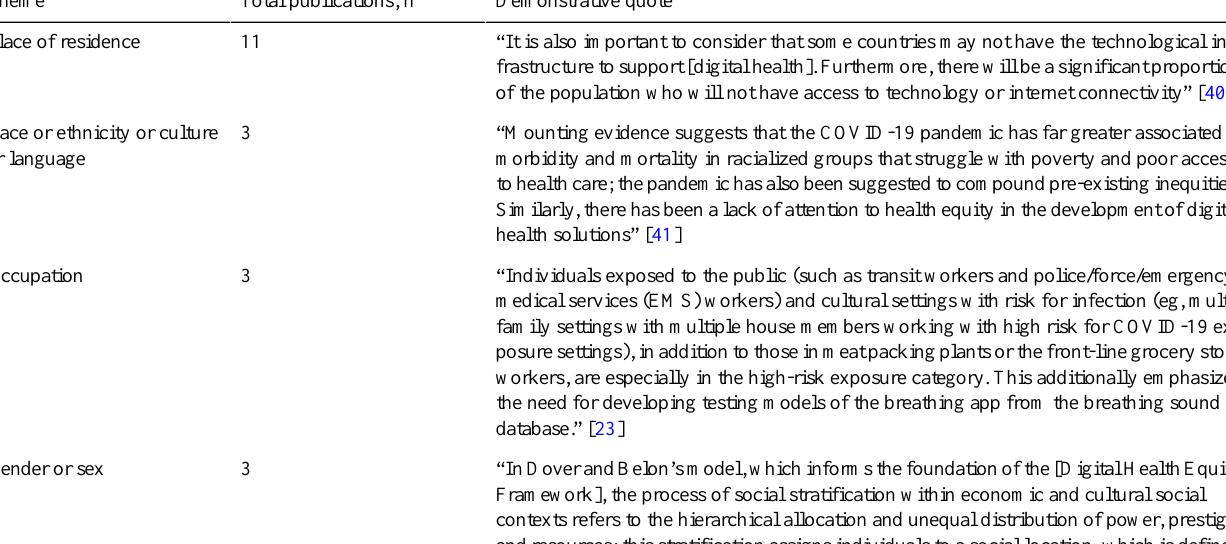
Demonstrative quoteTotal publications,